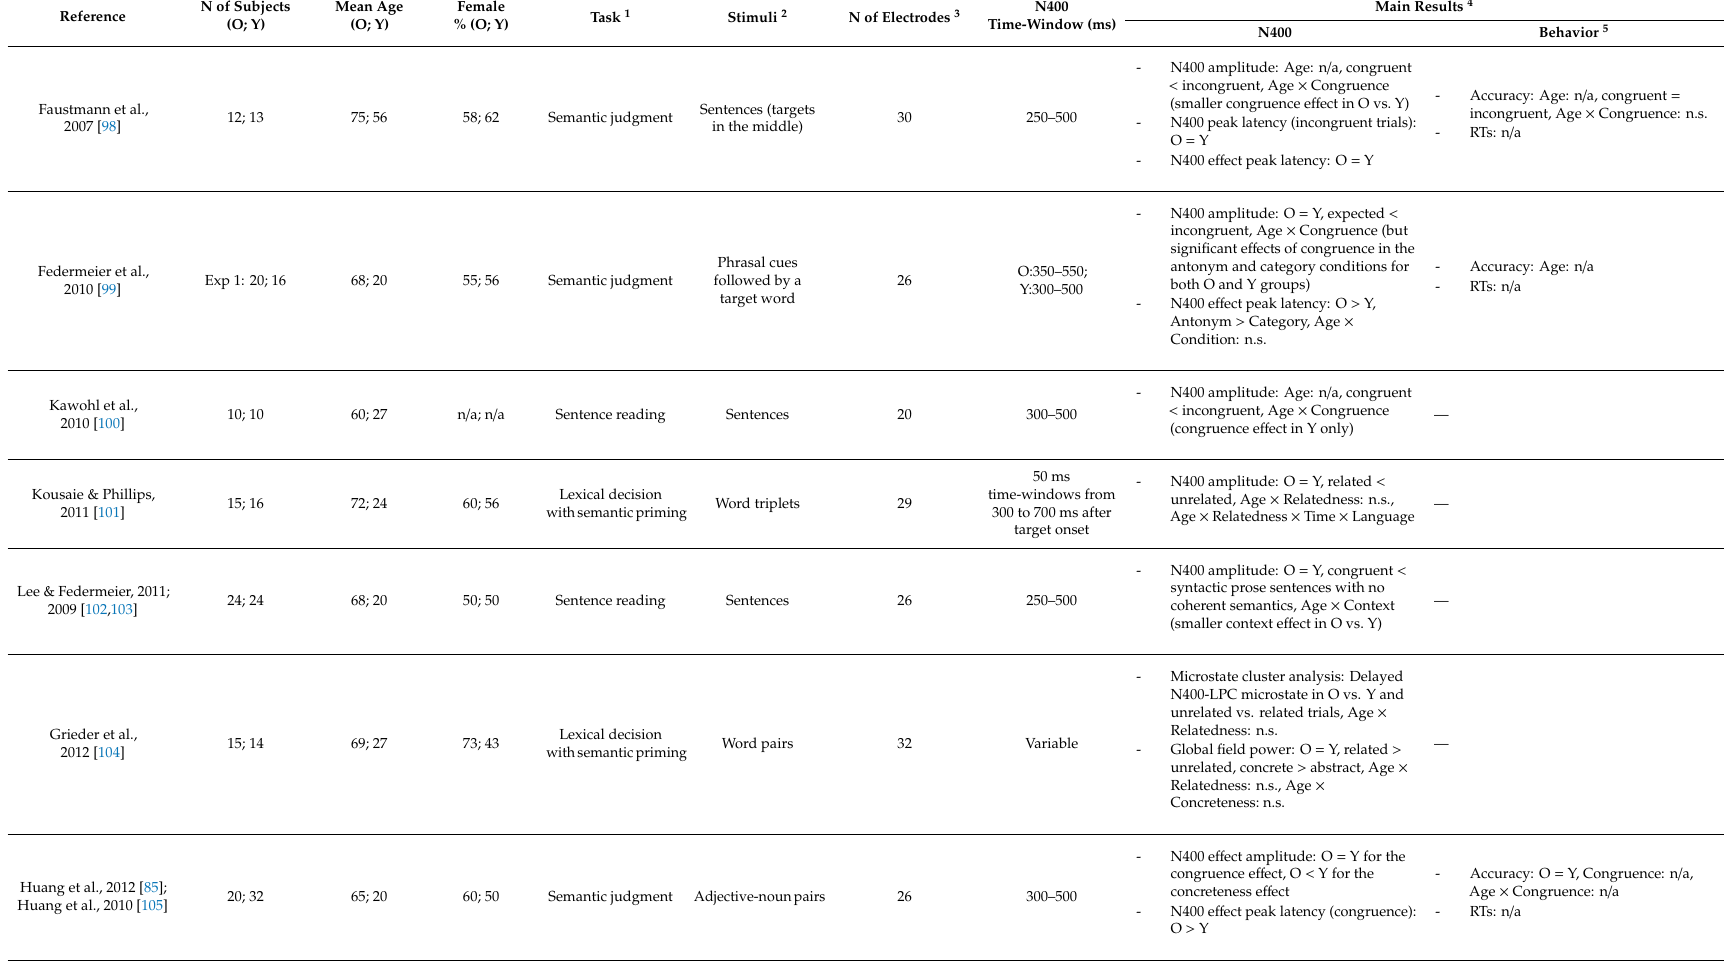
unrelatedvs. relatedtrials,Age × Relatedness: